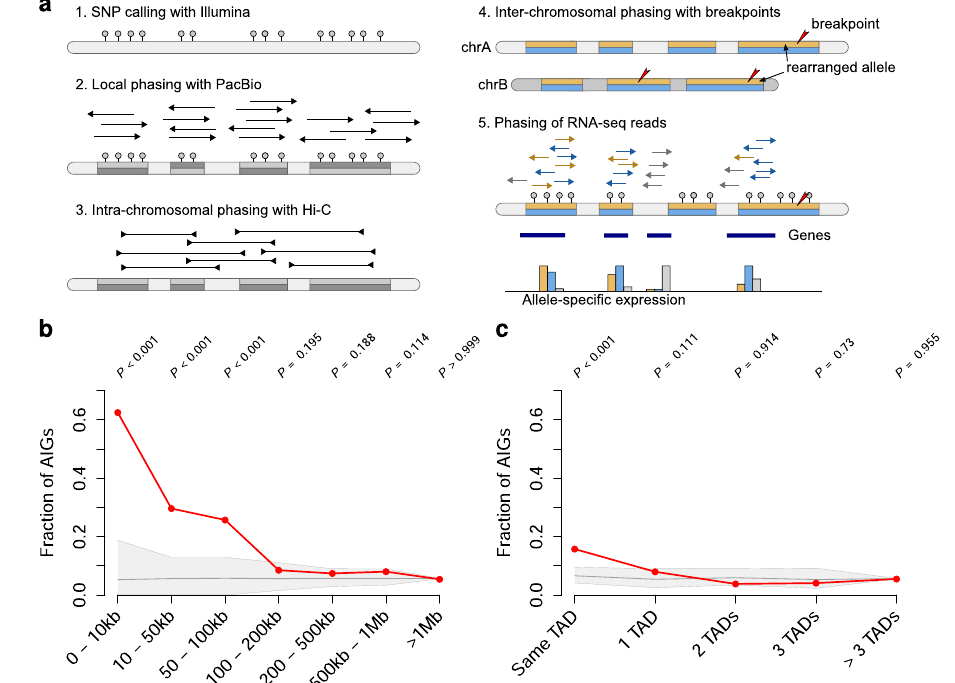
Fig. 4 | Haplotyping and allele-speci fi c analysisof RNA-seqdata. a Haplotyping: BasedonSNPsfromIlluminasequencinglargerhaplotypeblocksarecreatedusing PacBiolong-reads.LargehaplotypeblocksareconnectedwiththehelpofHi-C.The breakpoints of rearrangements are also phased and used to label WT allele and affected allele. The haplotype information is used to phase RNA-seq data at posi- tions with informative SNPs and to derive allele-speci fi c gene expression values. b Differential gene expression analysis around breakpoints: Fraction of allelic imbalance genes (AIGs) with respect to the distance between an expressed gene